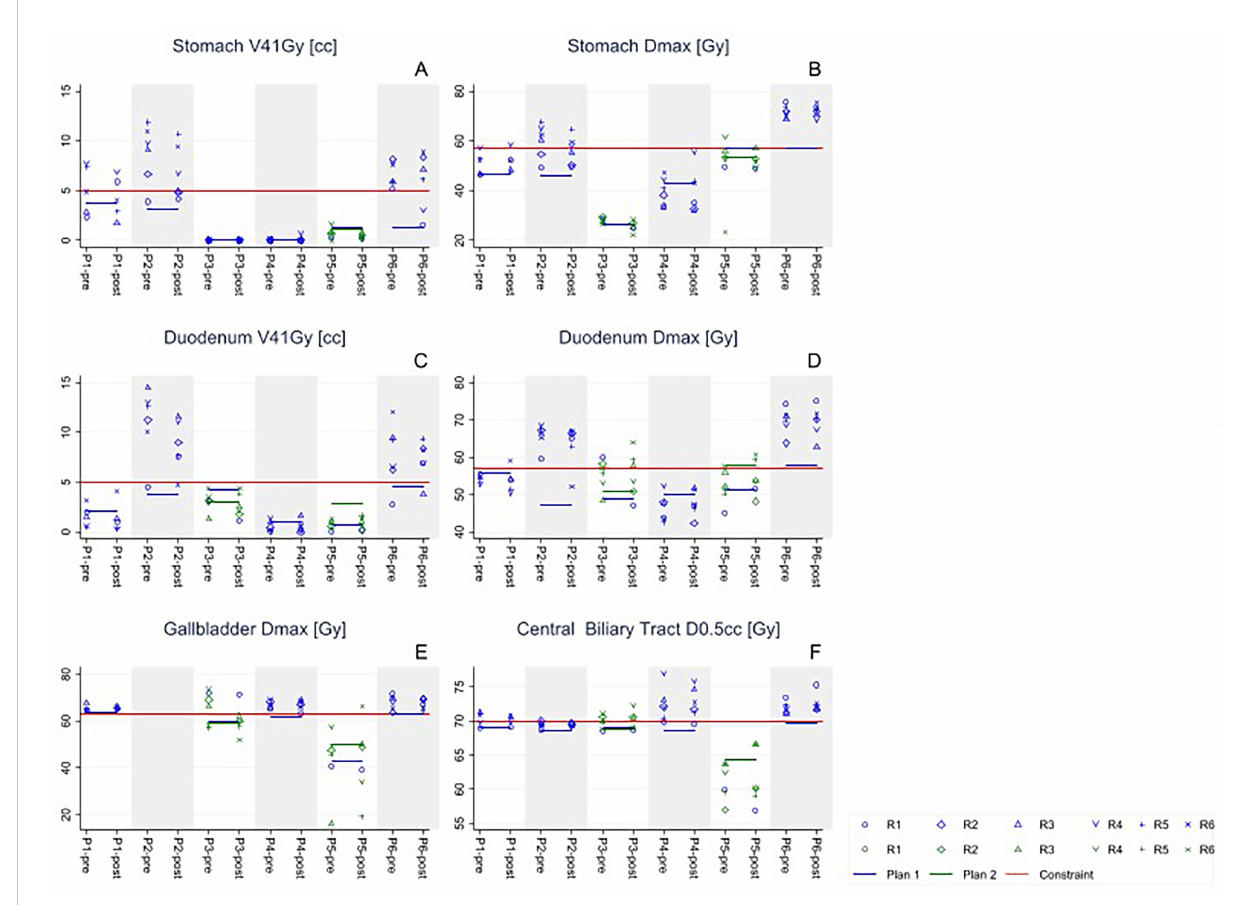
FIGURE 4 For all 6 study patients, P i , re-calculated stomach, duodenum, gallbladder and central biliary tract dose in repeat CT-scans, Rj, acquired pre- and post-dose delivery, compared to planned dose and planning constraints. For patients 3 and 5 there was an updated treatment plan during the fractionated treatment (Plan 2). Each panel analyzes a major constraint as described in the STRONG study (see Table